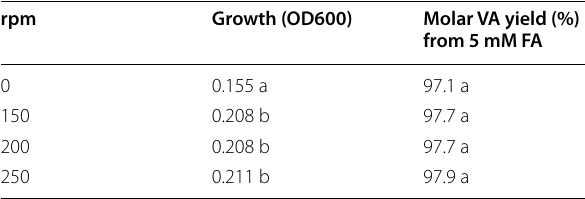
Data represent mean values of three replicates. Different letters (a, b) indicate statistically significant differences (LSD, p